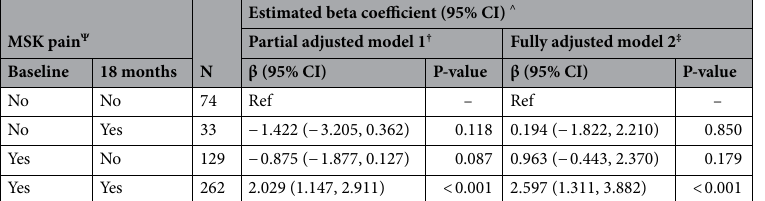
Table 3. Association of MSK pain transition groups and insomnia at 18 months (n = 498). ^ Abbreviations: CI, confidence interval; MSK, musculoskeletal; N, sample size; β, beta coefficient; Ψ No, people without MSK pain; Yes, people with MSK pain; † Adjusting for insomnia at baseline. ‡ Adjusting for age, gender, BMI, no. of comorbid diseases and insomnia at